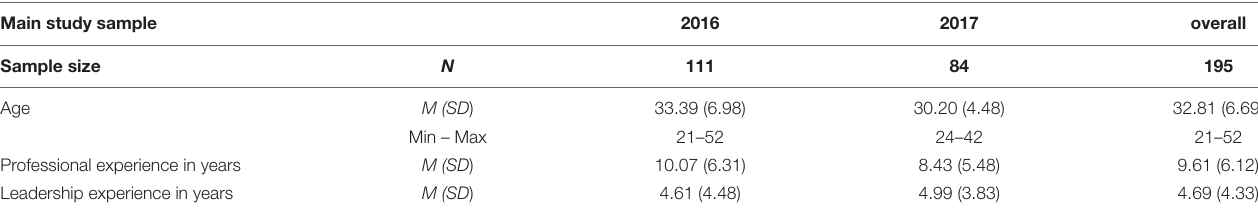
TABLE 3 | Age and years of professional and leadership experience of women in the main study sample, presented separately by contest years and overall. Main study